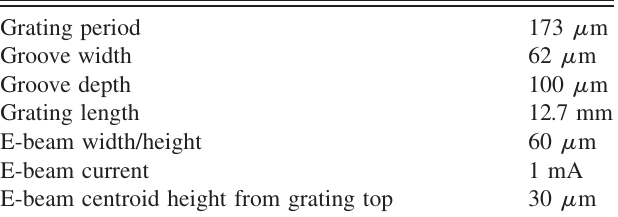
TABLE I. Example grating and beam parameters.